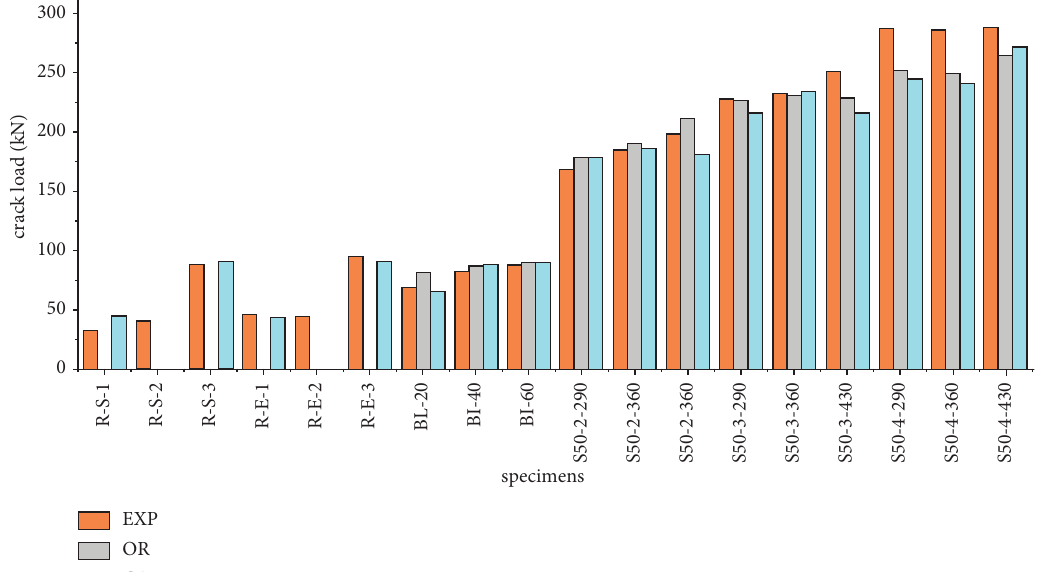
Figure 9: Comparison between the experimental value and the calculated value of cracking